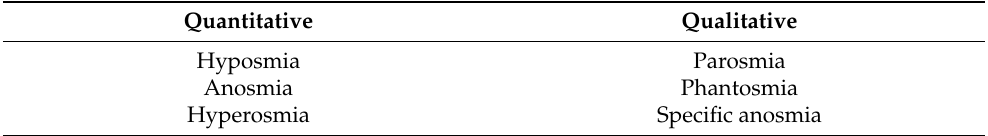
Table 1. Disorders of smell by